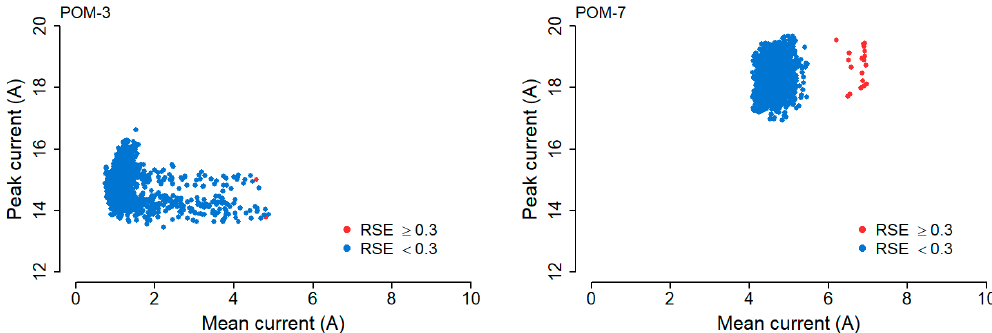
Figure 9. Mean current against Peak current of actuation signal data for point-operating machine POM-3 and POM-7. Data points of RSE values ≥ 0.3 (red), <0.3 (blue).